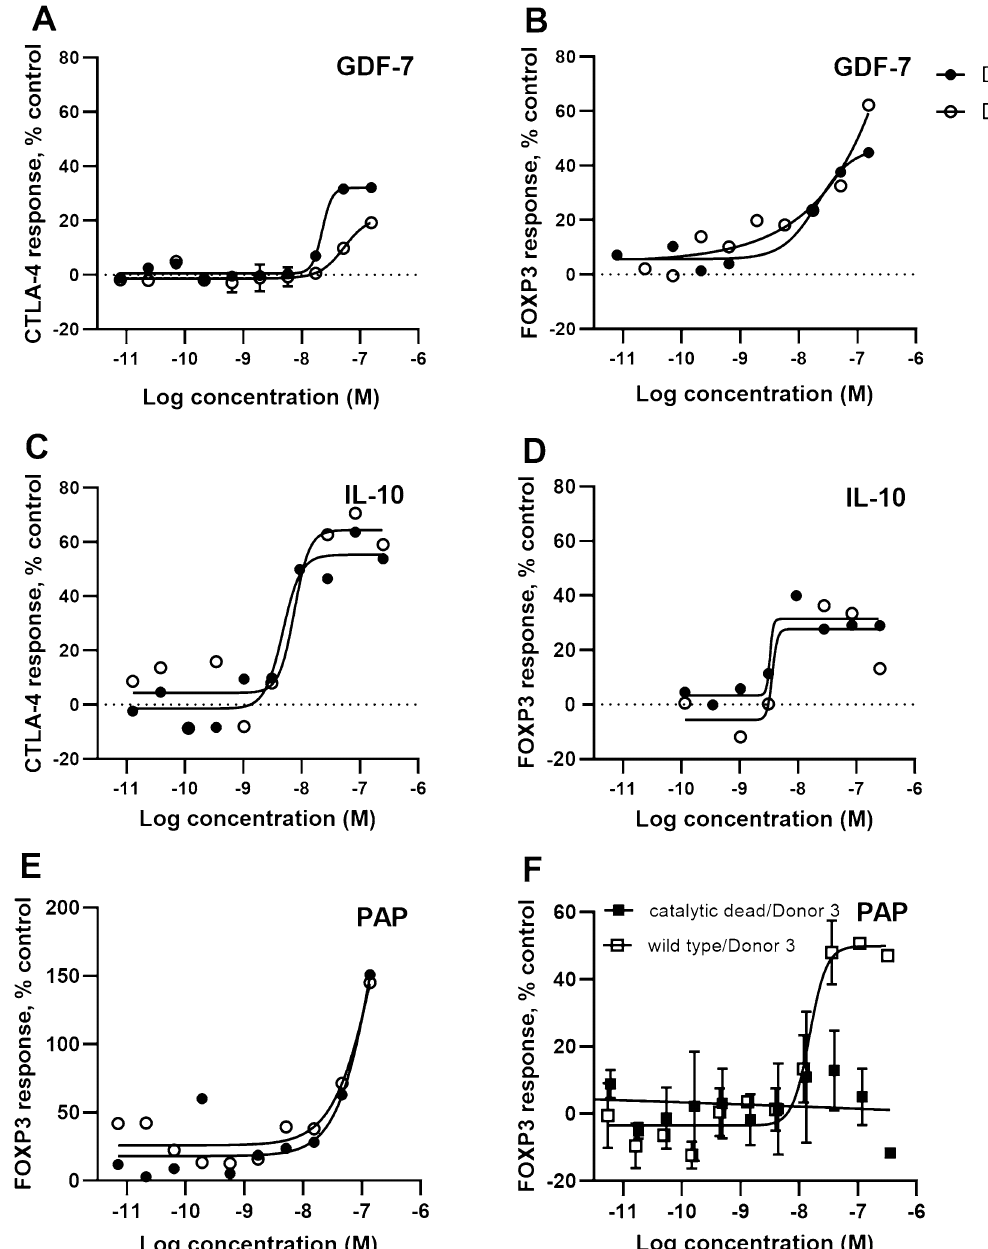
Figure 2. GDF-7, IL-10 and PAP stabilise the Treg markers. The concentration dependent effects on FOXP3 and CTLA4 protein expression induced by GDF-7, IL-10 and PAP are shown in ( A , B ) for GDF-7; ( C , D ) for IL-10; and ( E , F ) for PAP. The effect on FOXP3 and CTLA4 expression was normalized to % activity as compared to the MFI of live cells treated with the on-plate PBS neutral controls. These proteins were tested in human Treg cells from multiple donors (Donor 1 filled circle , Donor 2 empty circle ○ , Donor 3 empty square □ for wild type PAP, Donor 3 filled square ■ for catalytic dead mutant PAP ●